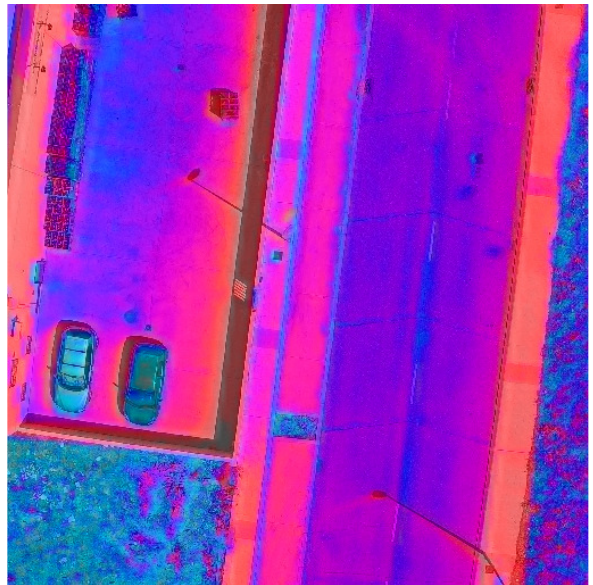
Figure 3. Enhanced thermal image in false color by the IHS pansharpening algorithm, from the UAV image dataset